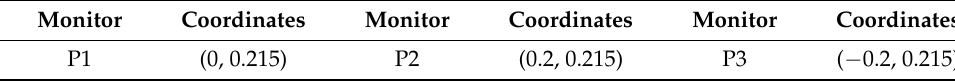
Table 3. Coordinates of pressure monitoring points.